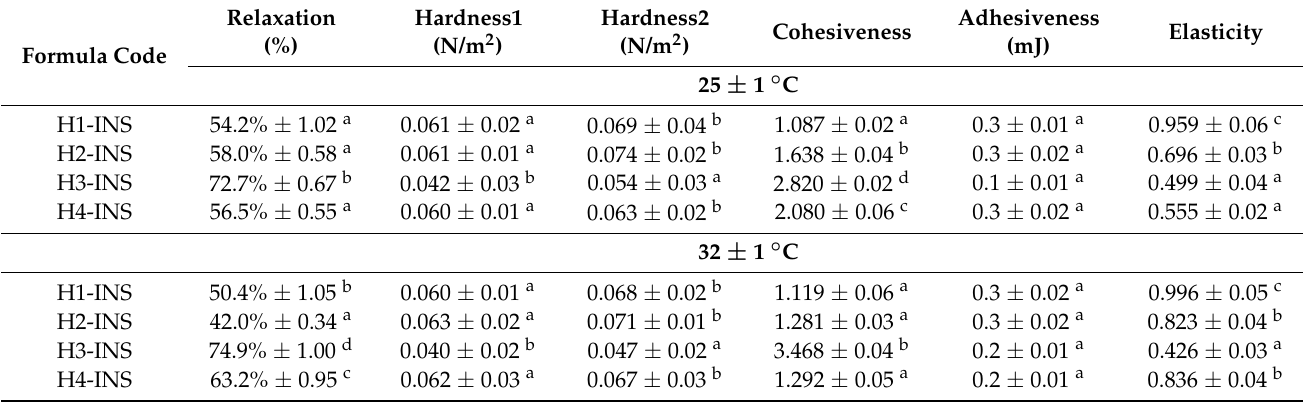
Table 6. Textural parameter values of hydrogels (mean ± SD, n =